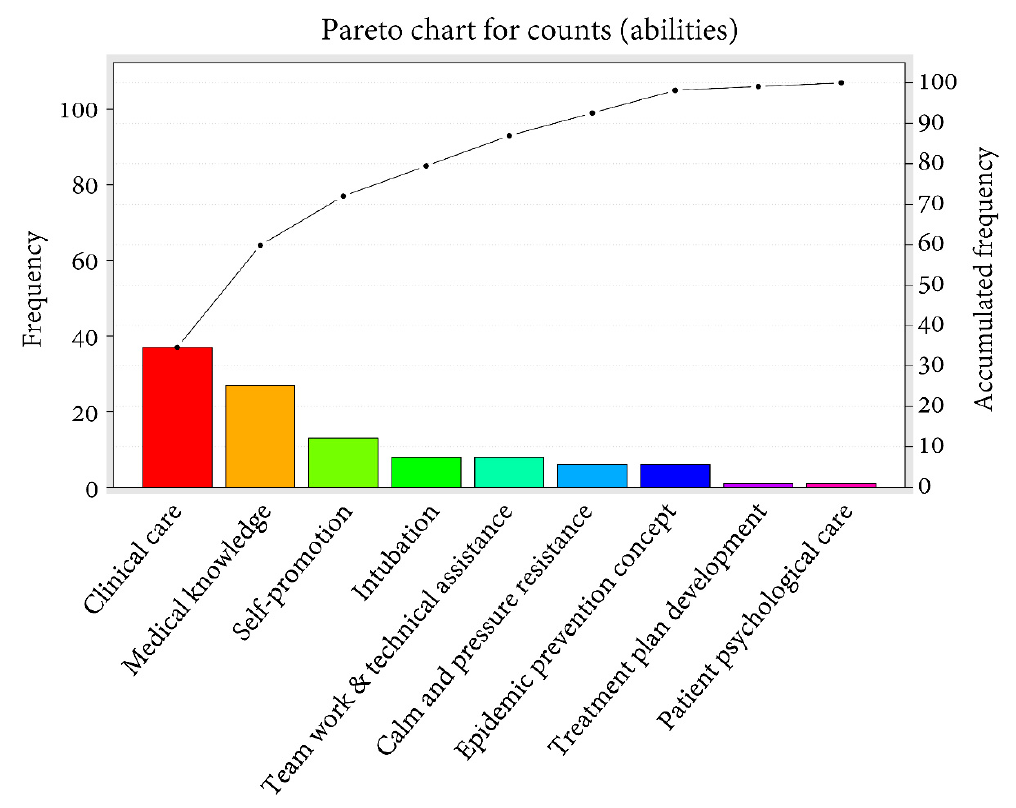
Figure 1. Pareto chart of the count of answers to questions regarding the abilities of the participants.